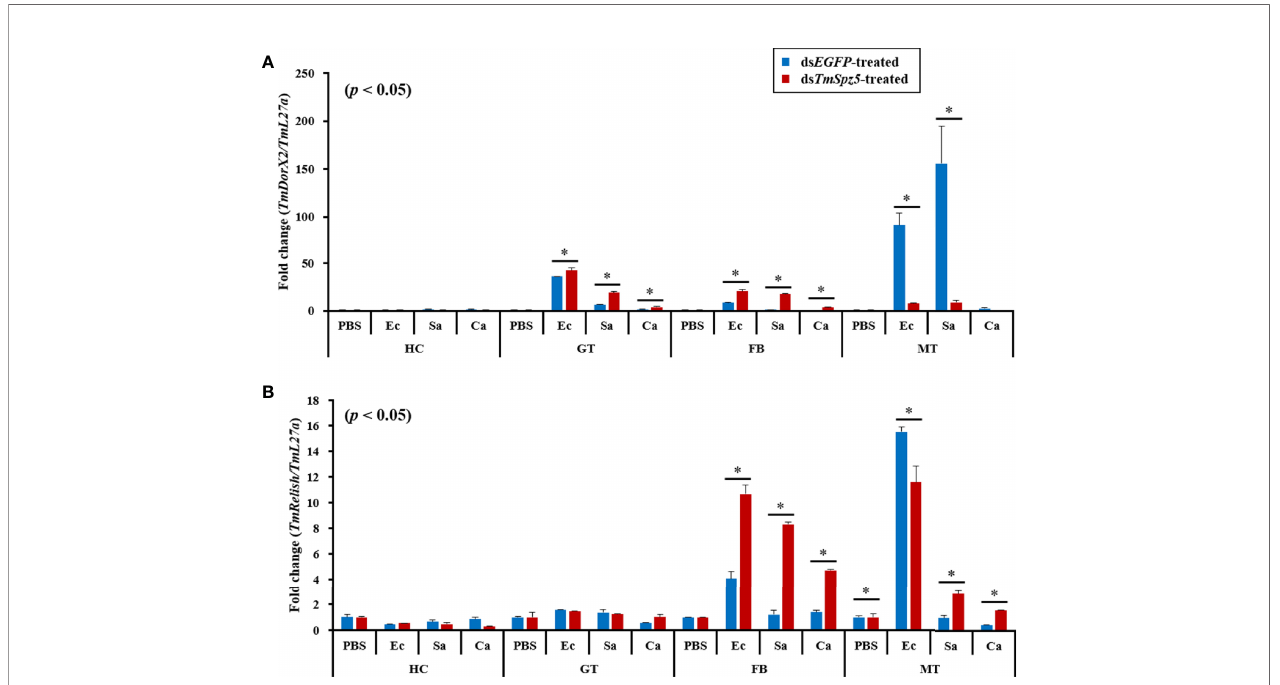
FIGURE 10 | Effect of Tmspz5 gene silencing on NF- k B gene expression patterns. ds Tmspz5 -treated T. molitor larvae were infected with E . coli , S. aureus and C. albicans and 24 h post-pathogen injection, mRNA levels of NF- k B genes, including TmDorX2 (A) and TmRel (B) , were measured by RT-qPCR. EGFP dsRNA was assessed as a negative control and T. molitor ribosomal protein ( TmL27a ) was used as an internal control. All experiments were performed in triplicate. Asterisks indicate signi fi cant differences between ds TmSpz5 - and ds EGFP -treated groups determined using Student ’ s t -test ( p <